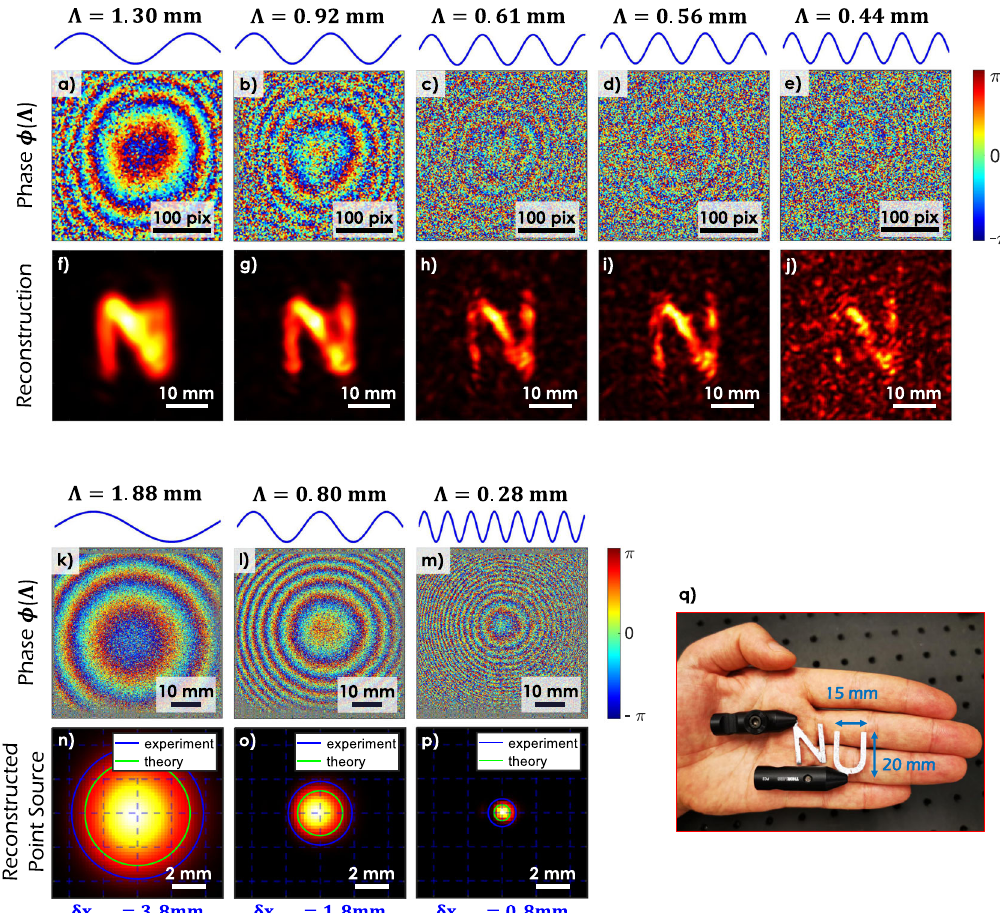
Fig. 2 Experimental demonstration of looking around corners using SWH and an assessment of its resolving power. a – j Imaging the character ‘ N ’ (~15 mm × 20 mm) around the corner at fi ve different SWLs. A schematic of the experimental setup is available in Fig. 1b. a – e The phase of the synthetic holograms at the VD surface. f – j Respective reconstructions (squared magnitude of the backpropagated synthetic fi elds at the standoff distance of the character). The resolution of the reconstructions increases with decreasing SWL. However, the speckle-artifacts increase due to the decorrelation of the two optical fi elds at λ 1 and λ 2 . k – p Synthetic diffraction disc: reconstruction of an obscured point source for three different SWLs. k – m Phase of the synthetic holograms at the VD surface. n – p Reconstruction of the ‘ synthetic diffraction disc ’ . As in classical optics, the disc size varies linearly with the wavelength (in this case the SWL). The experimental value is close to the theoretical expectation. For p , the point source is reconstructed with sub-mm precision. q Image of the targets used in the experiments of this paper: Two characters ‘ N ’ and ‘ U ’ with dimensions~ 15 mm × 20 mm (plus black Fig. 1c. In a fi rst set of measurements, we image the small character ‘ U ’ (dimensions 15 mm × 20 mm, see Fig. 2q) through a